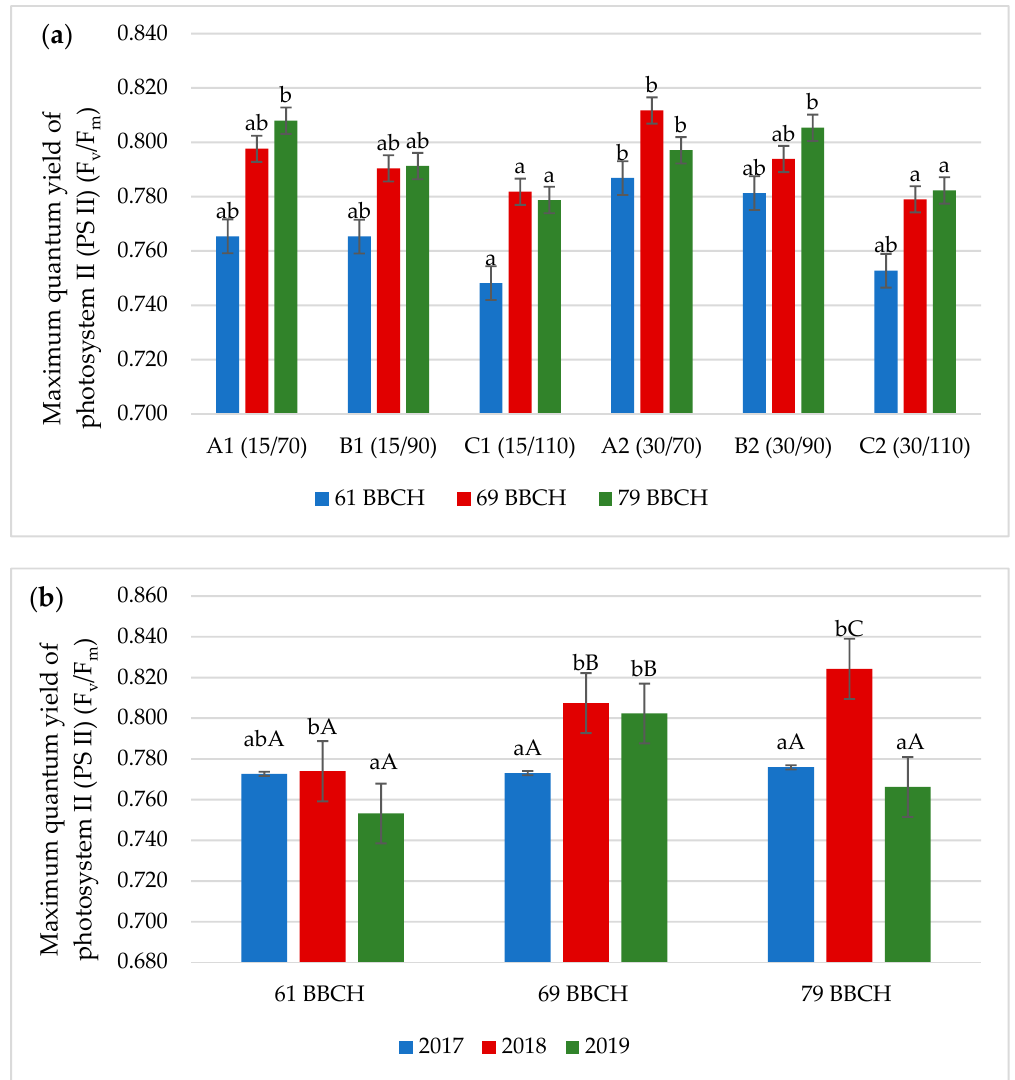
Figure 3. Effect of row spacing and sowing density on maximum quantum yield of photosystem II (PSII)—F v /F m in soybean leaves ( a ) between variants of the experiment during the 3-years study ( b ) between years of research. Lowercase letters indicate significant differences between the means in the measurement phases, capital letters indicate significant differences between means in the years of research according to ANOVA (followed by Tukey’s HSD test, p =